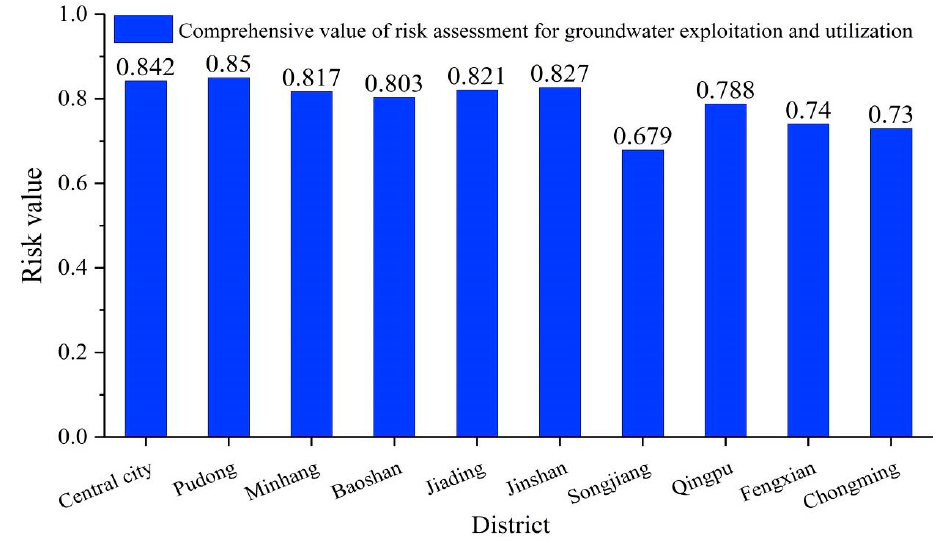
Figure 8. Target layer risk values for groundwater exploitation and utilization risk in Shanghai.